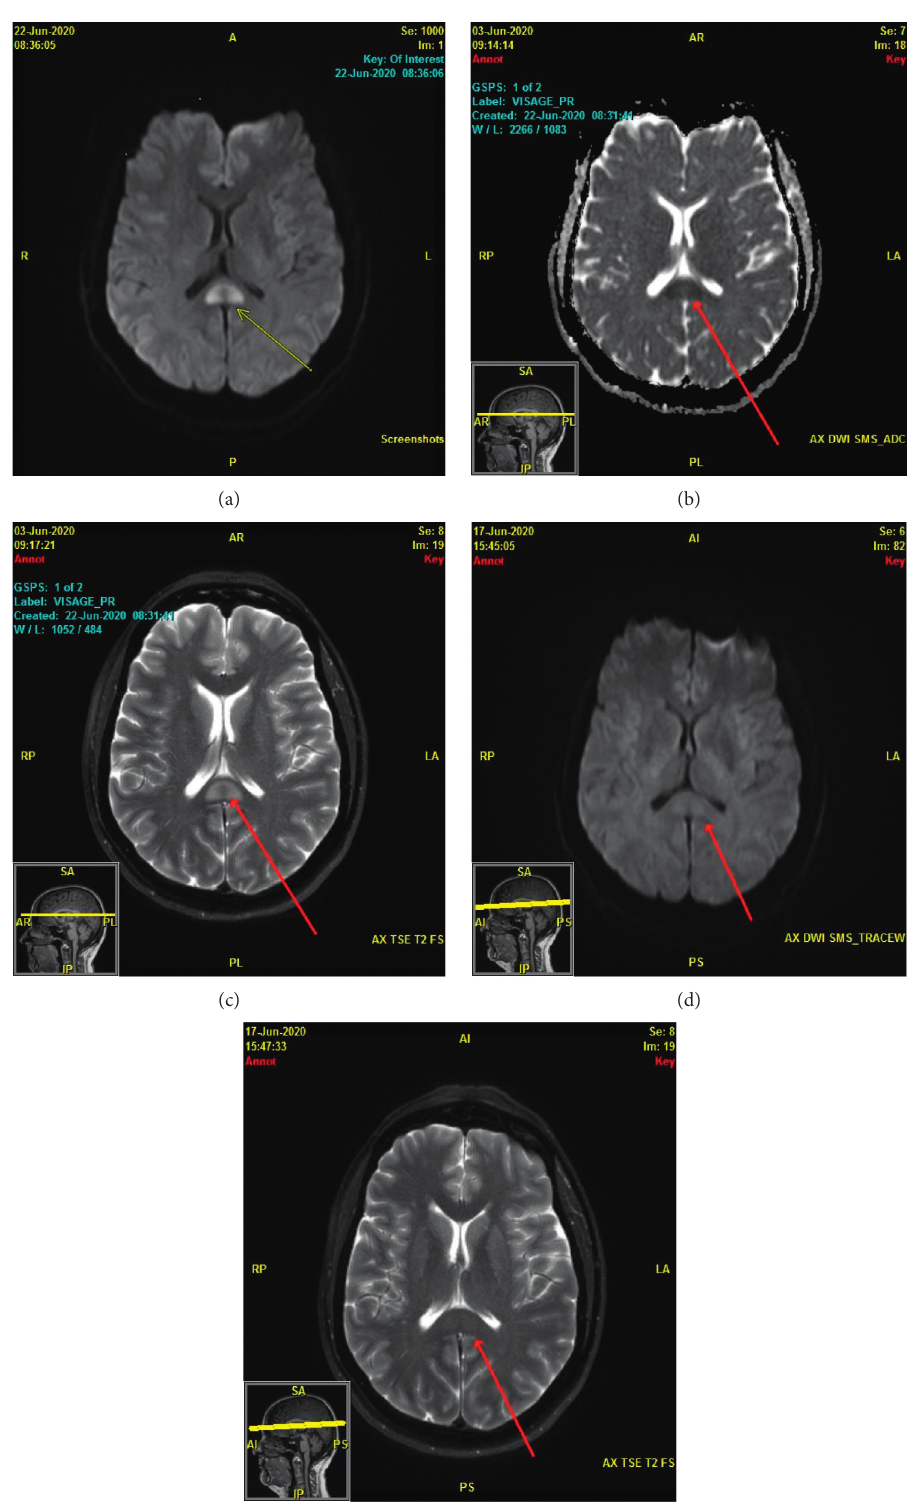
Figure 1: (a–c) MRI brain completed 16 days after lumbar puncture demonstrating an oval-shaped focus of abnormal unenhancing T2/ FLAIR hyperintensity with restricted diffusion of the splenium of the corpus callosum (arrow). (a) Axial diffusion. (b) ADC mapping confirms true restricted diffusion. (c) Axial T2. (d, e) MRI brain completed 14 days after initial MRI with near-to-complete resolution of the corpus callosum lesion (arrow). (d) Axial diffusion. (e) Axial